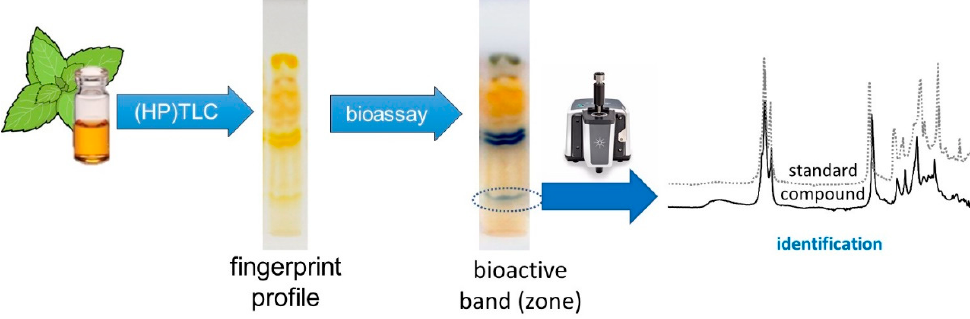
Figure 1. Overview of hyphenated (HP)TLC with ATR-FTIR identification as a tool in the Effect-Directed Discovery of bioactive compounds in plant extracts .